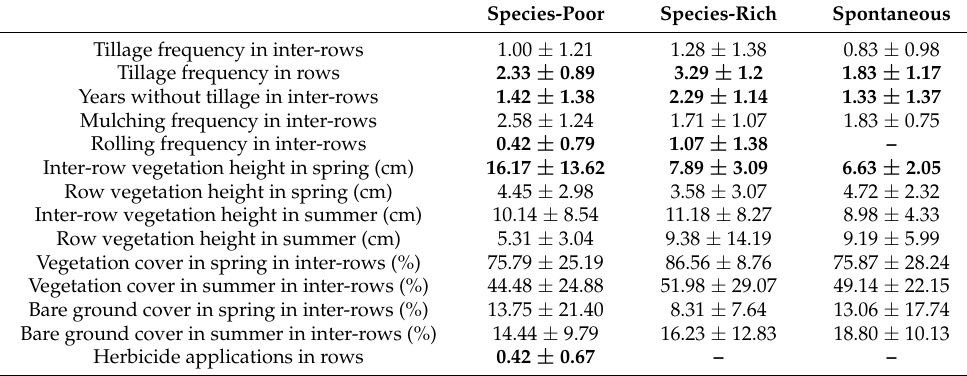
Table 2. Treatment variables of vineyards with different cover-crop management (mean ± standard deviation). Bold numbers display variables that are significantly different among species-poor, species-rich, and spontaneous vegetation cover. Tillage frequency differs in neighboring inter-rows; therefore, management measures were displayed for the inter-row in which vegetation data was collected in spring and summer. Species-Poor Species-Rich Spontaneous Tillage frequency in